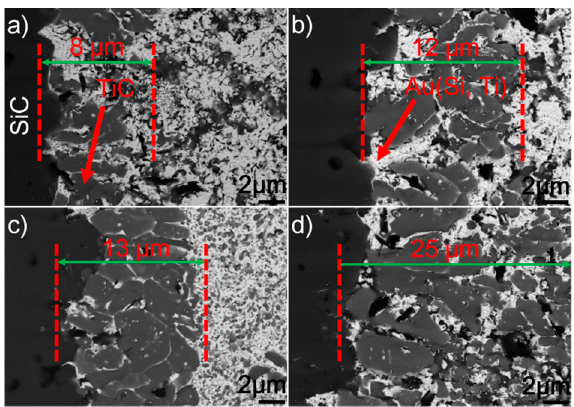
Figure 6. BSE images showing the reaction layer at the SiC/braze interface obtained for 10 min at ( a ) 1423 K, ( b ) 1473 K, ( c ) 1523 K, and ( d ) 1573 K.